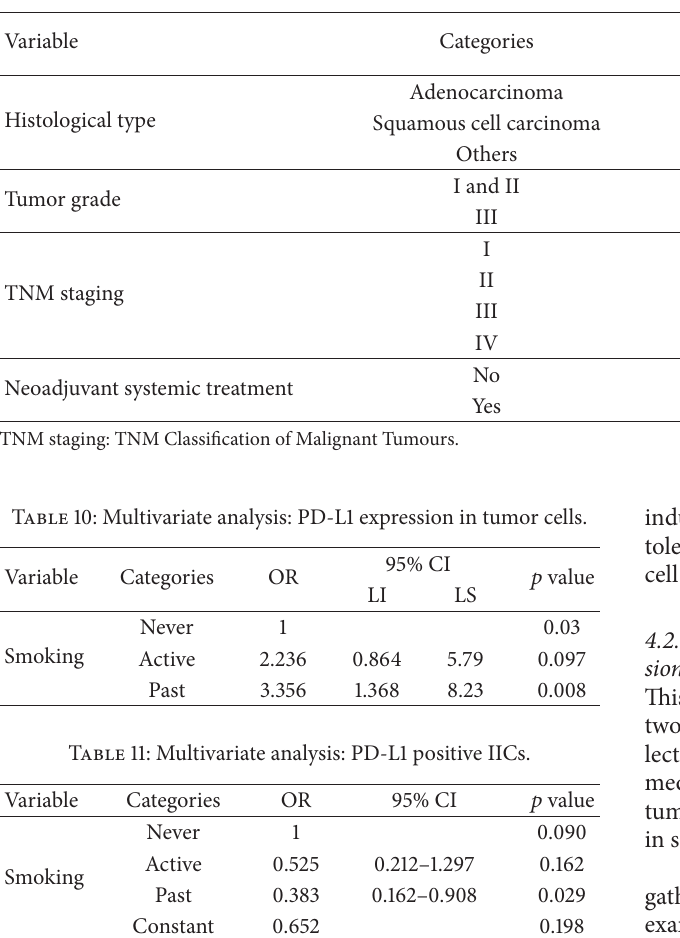
Table 9: PD-L1 expression in antigen presenting cells and clinical data.